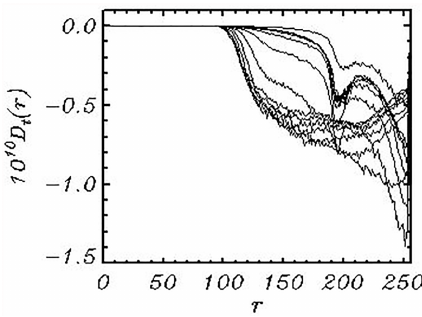
Figure 8. The tail dissipation spectra D t (r) integrated over angle ψ in the polar coordinates and averaged over the consequent intervals of length for about 100 units of the nondimensional time t .